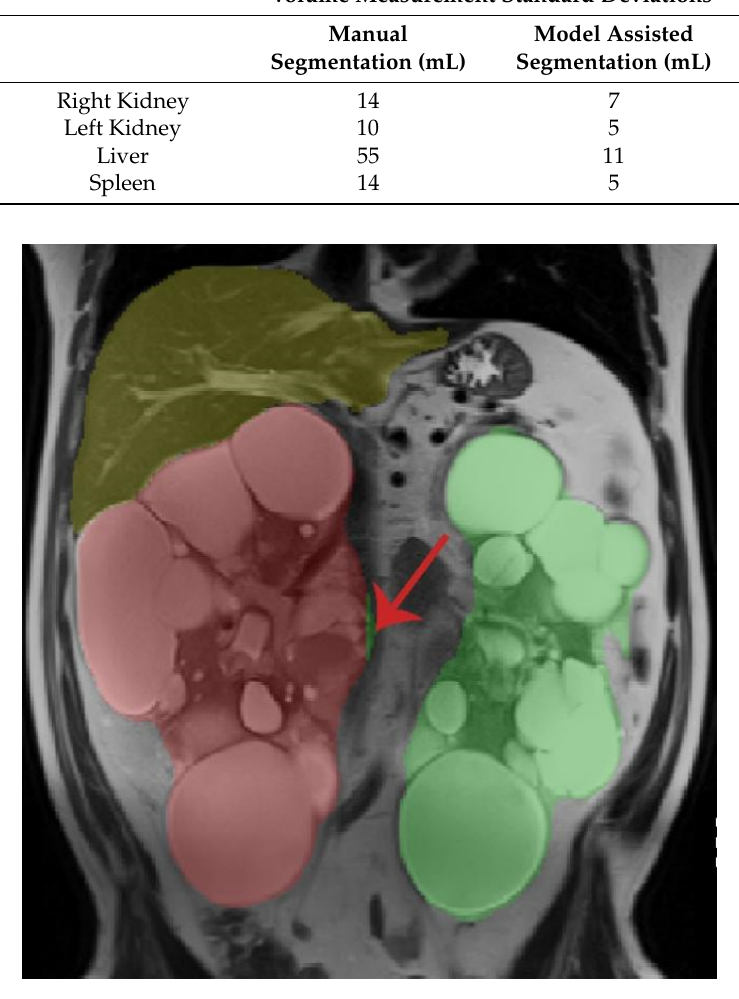
Figure 7. Coronal T2 weighted image from a 61-year-old male with ADPKD showing correctly labeled liver (yellow) and left kidney (green). Right kidney (red) is mostly correct but has a thin vertical sliver (red arrow) that crossed the midline and became labeled as left kidney (green).